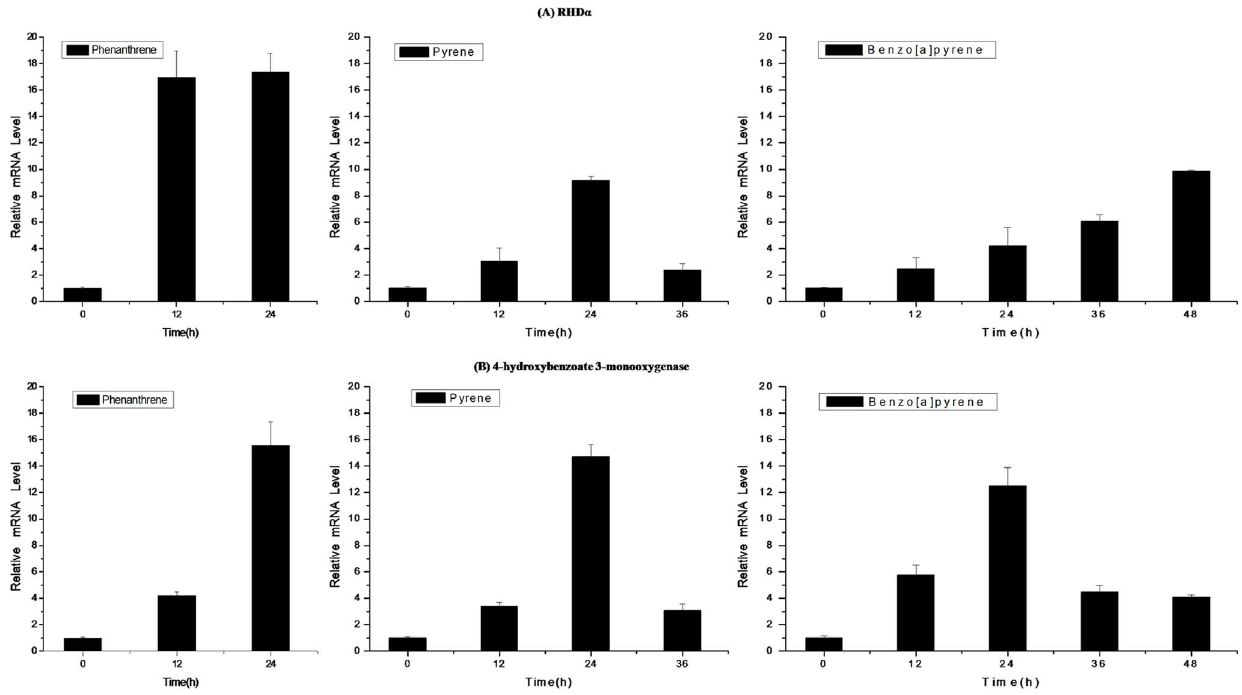
Figure 4. Relative quantification of RHD a (A) and 4-hydroxybenzoate 3-monooxygenase (B) gene expression in Novosphingobium pentaromativorans US6-1 following induction by three PAH compounds (mean and standard deviation of triplicate samples are shown).